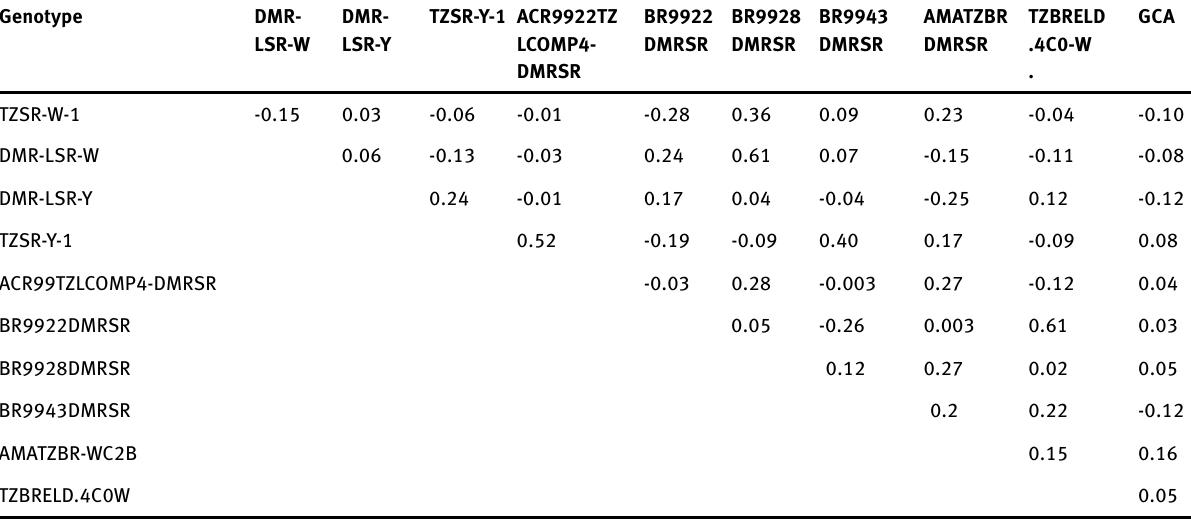
Table 5: General and Specific combining ability (GCA and SCA) for maize grain yield across Low-N environment (Mokwa and Zaria, 2012)